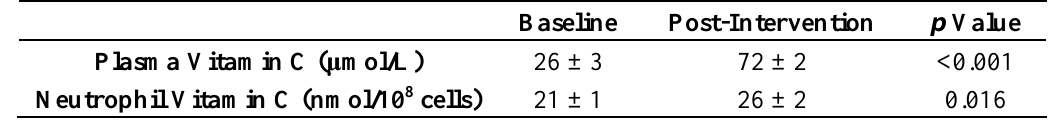
Table 2. Vitamin C content of plasma and neutrophils at baseline and following